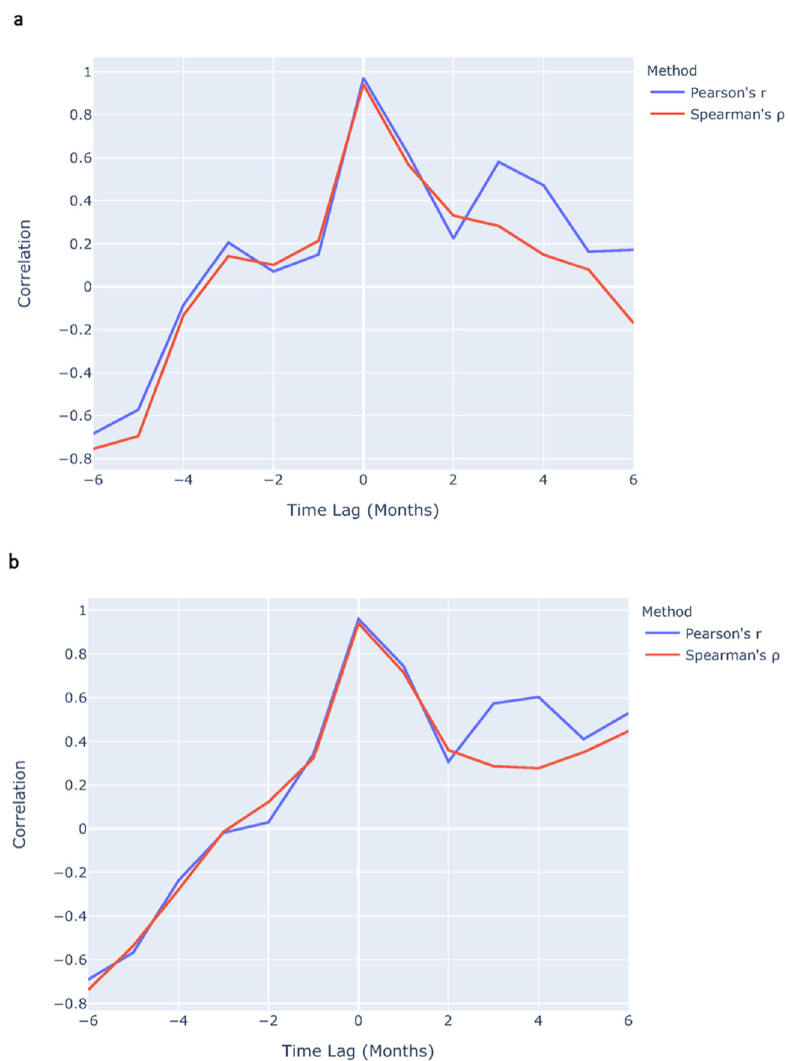
Fig. 2 Time-lagged correlations of search volume vs. backgrround checks. a Internet search volume for “ shotgun ” and long-gun background checks in 2019. b Internet search volume for “ 9 mm ” and handgun background checks in